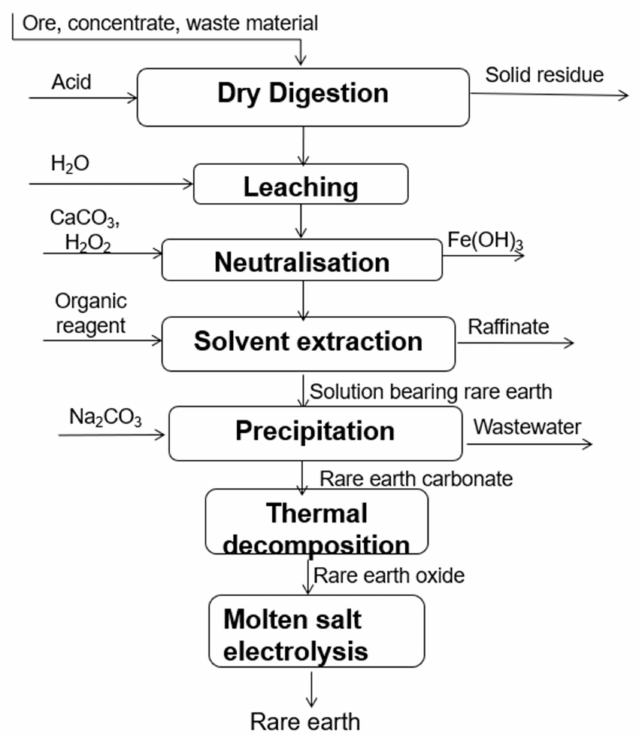
Figure 1. One combined hydrometallurgical and pyrometallurgical process for the production of rare earth